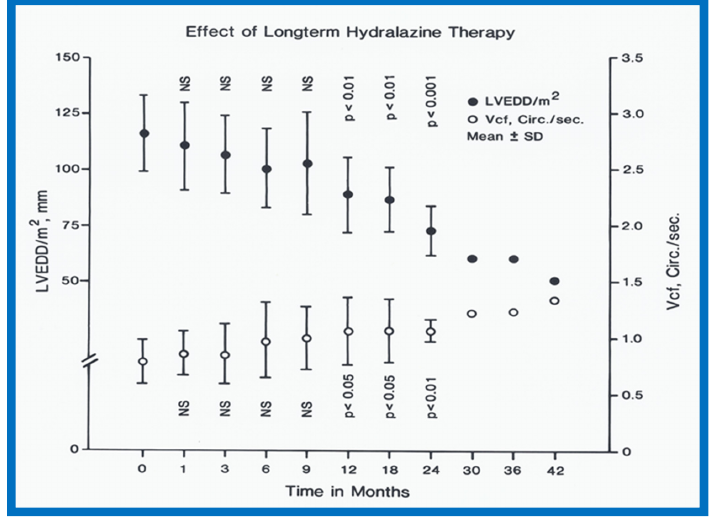
Figure 38. Left ventricular end ‐ diastolic dimension (LVEDD)/m 2 in mm (closed circles) and velocity of circumferential fiber shortening (Vcf) in circumferences/sec (open circles) are shown from prior to start of hydralazine therapy (0) and at 1, 3, 6, 9, 12, 18, 24, 30, 36 and 42 months following initiation of hydralazine therapy. Means and standard deviations (SD) are shown. The number of subjects at 30, 36 and 42 months is small, and therefore, only mean values are shown. Note the gradual improvement in LVEDD and Vcf. Statistically significant ( p < 0.05 to < 0.01) change becomes apparent from 12 months follow ‐ up onwards. Reproduced from Rao P.S., Andaya W.G. [12].